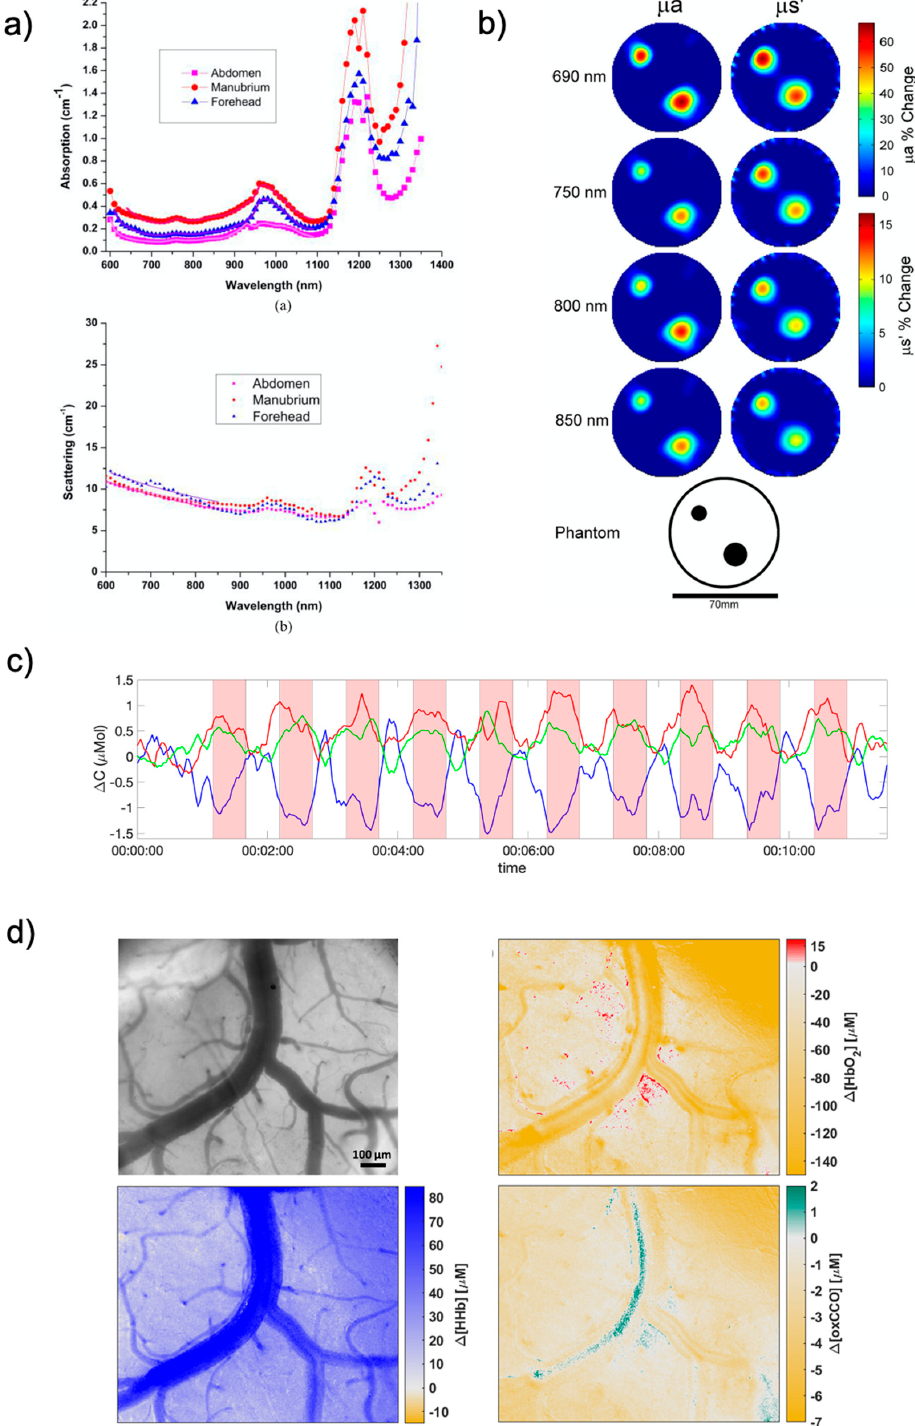
Figure 3. Example of typical data extracted form system based on SCL as sources. ( a ) absorption and reduce scattering coefficient of several tissues acquired the TD-NIRS system developed in ref [23]. Figure reproduced from [23]. ( b ) 2D maps of the changes in optical properties of a phantom using MONSTIR II. (reproduced with permission from [28], Copyright AIP Publishing, 2021). ( c ) Changes in [HbO2] (red), [HHb] (blue) and [oxCCO](green), in the occipital lobe, acquired with the MAESTROS system [24], during a typical brain activation. Data presented at the fNIRS conference in Tokyo in 2018. ( d ) Raw image and reconstructed variation in [HbO2], [HHb], and [oxCCO] acquired on the exposed cortex during anoxia. (reproduced with permission from [25], Copyright IEEE,